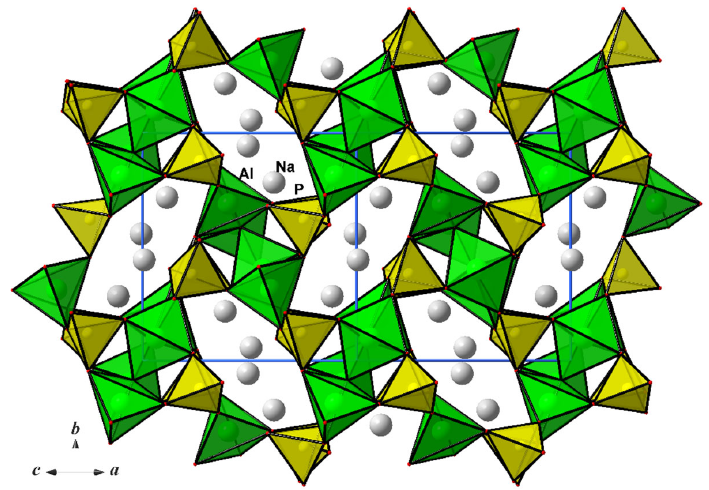
Figure 4. The Na 2 Al 2 O(PO 4 ) 2 ∙ 0.12H 2 O crystal structure viewed along the [101]